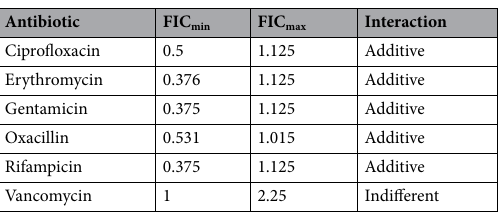
Table 3. Minimum and maximum Fractional Inhibitory Concentration (FIC) indices of antibacterial agent/ 135C